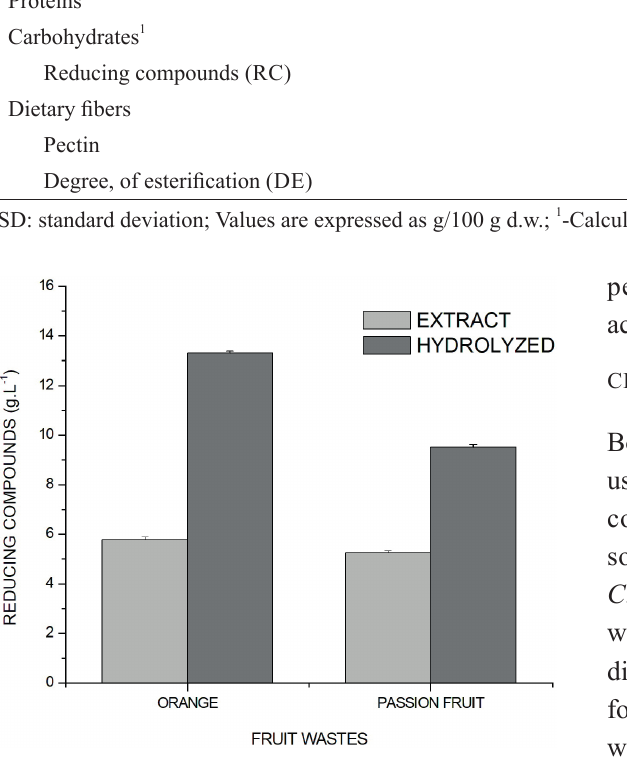
Figure 1 - Concentration of reducing sugars of the fruit wastes extracts before and after enzymatic hydrolysis using polygalacturonase (10.0 UI/g of